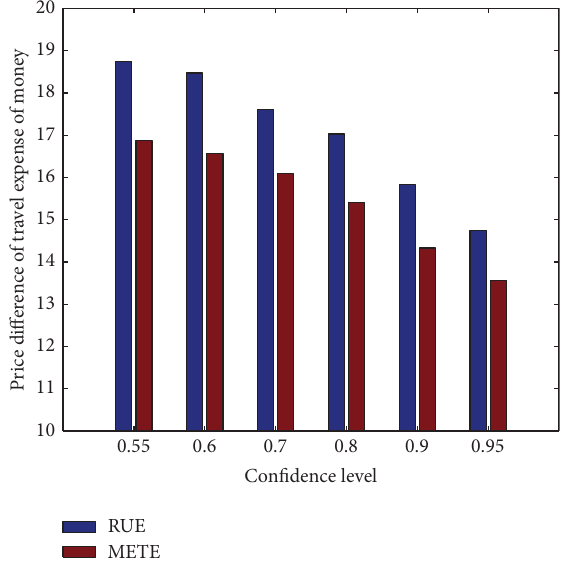
Figure 3: Confidence levels versus the price difference on money.